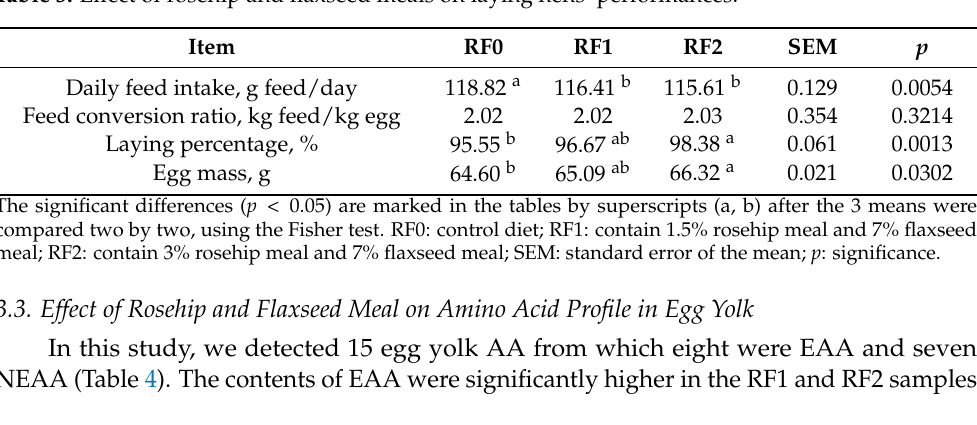
Table 3. Effect of rosehip and flaxseed meals on laying hens’